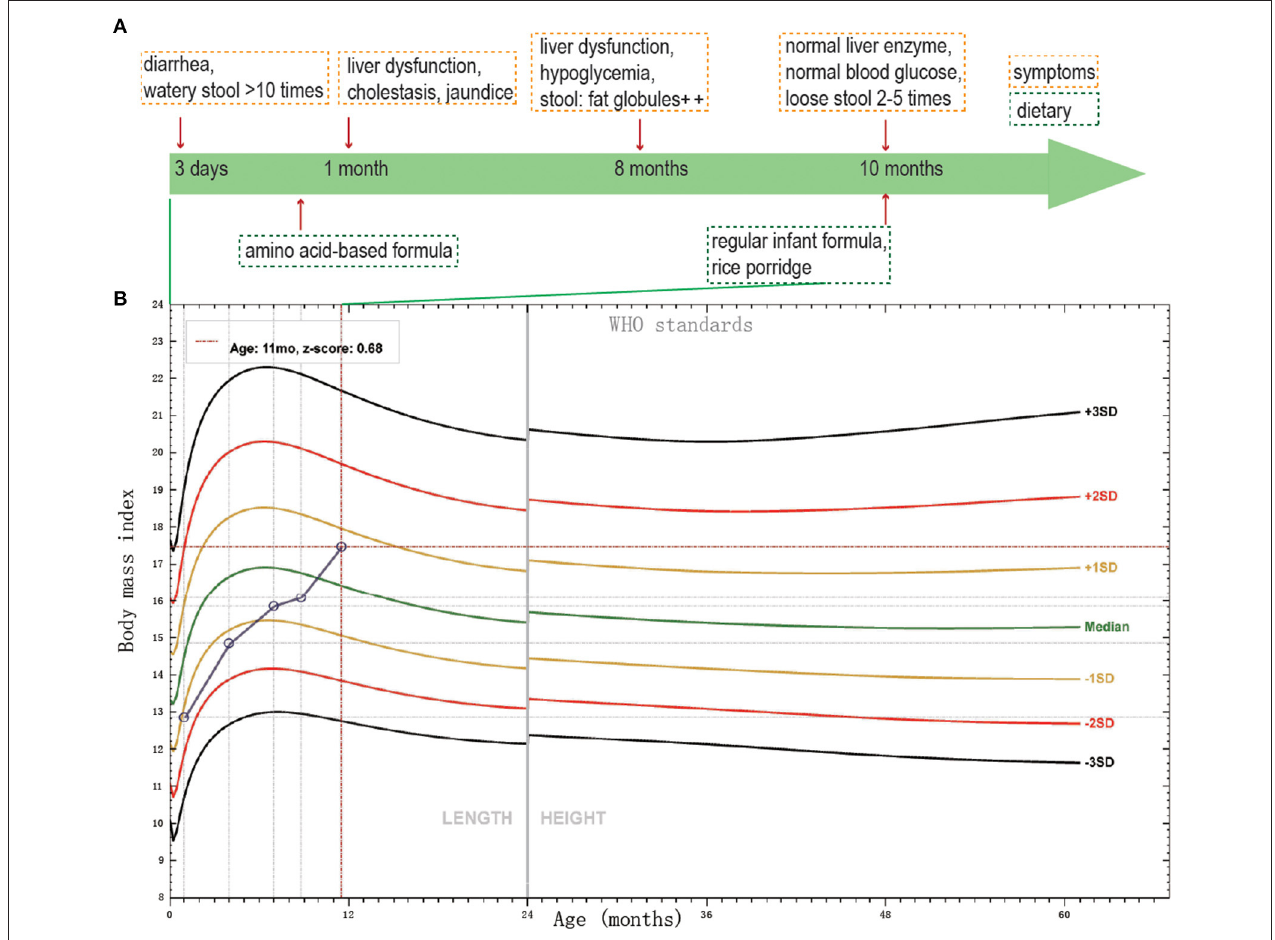
FIGURE 1 | The thriving records of clinical features of the patient. (A) The clinical symptoms and dietary of the patient. (B) BMI SD score of the proband, according to WHO standards, from birth to age 11